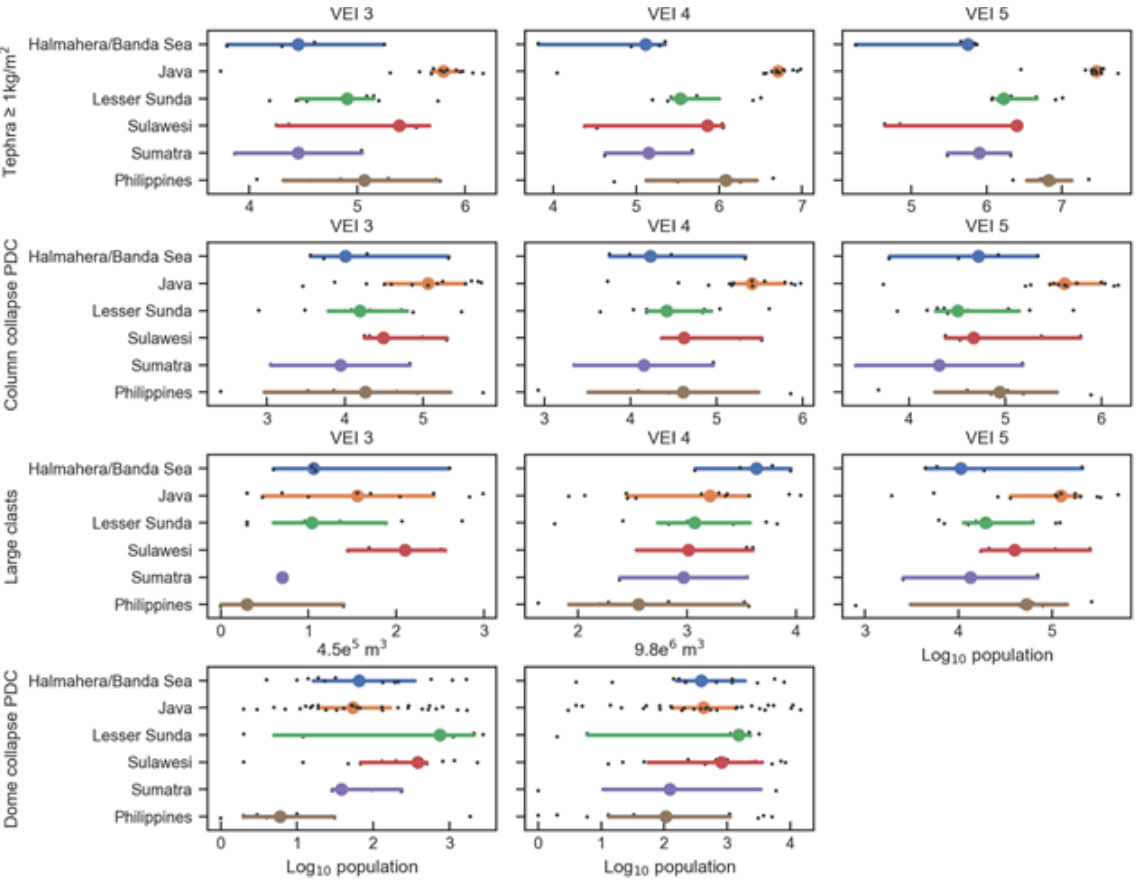
Figure 5. Distribution of the population exposure for each volcano colour-coded by region. The horizontal bars and the coloured circles show the 95% confidence interval and the median, respectively, whereas the small dark dots show the underlying data. Each column is a different eruption scenario (i.e. flow volume for dome collapse PDC and VEI otherwise). The hazard used here considers a conditional exceedance probability of occurrence of 50%. The number of volcanoes in each region are as follows: Halmahera/Banda Sea (4), Java (13), Lesser Sunda (10), Sulawesi (5), Sumatra (2), and the Philippines